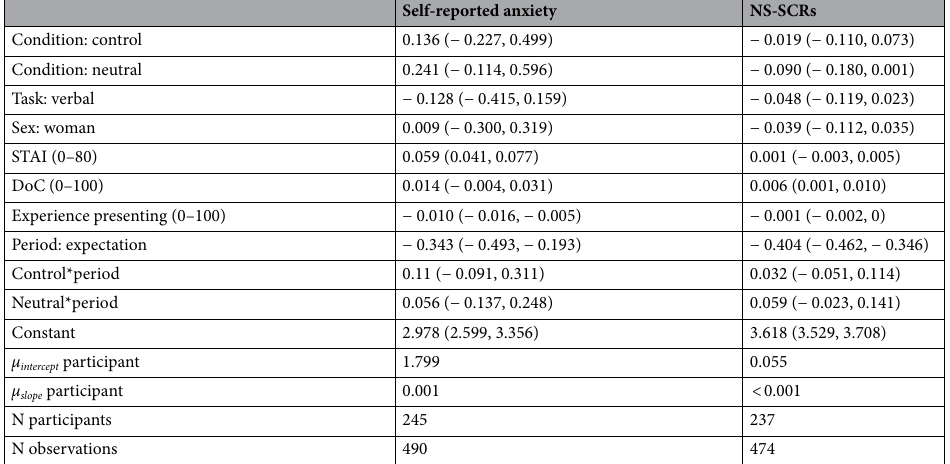
Table 1. Beta-Estimates from GLMM with 95% CI (the pre-registered analyses). Self-reported anxiety was modeled using the Tweedie distribution with log link while the number of NS-SCRs was modeled using the negative binomial distribution with log link. Condition shows the difference in the value of the outcome variable in the speech-preparation period between the ritualized condition and the control and neutral conditions, respectively. Task shows the difference between the motor and verbal tasks. STAI = State-trait anxiety inventory. DoC = Desirability of Control scale. STAI, DoC, and Experience were centered at their means. Period shows the difference in the outcome variables between the speech-preparation and expectation periods in the ritualized condition. Control*Period shows the difference in the slopes of the period variable between the ritualized and control conditions and Neutral*Period shows the difference in the slopes of the period variable between the ritualized and neutral conditions (our main comparison). µ inttercept Participant is the variance explained by varying intercepts by participants. µ slope Participant is the variance explained by varying the slopes of baseline anxiety by participants.